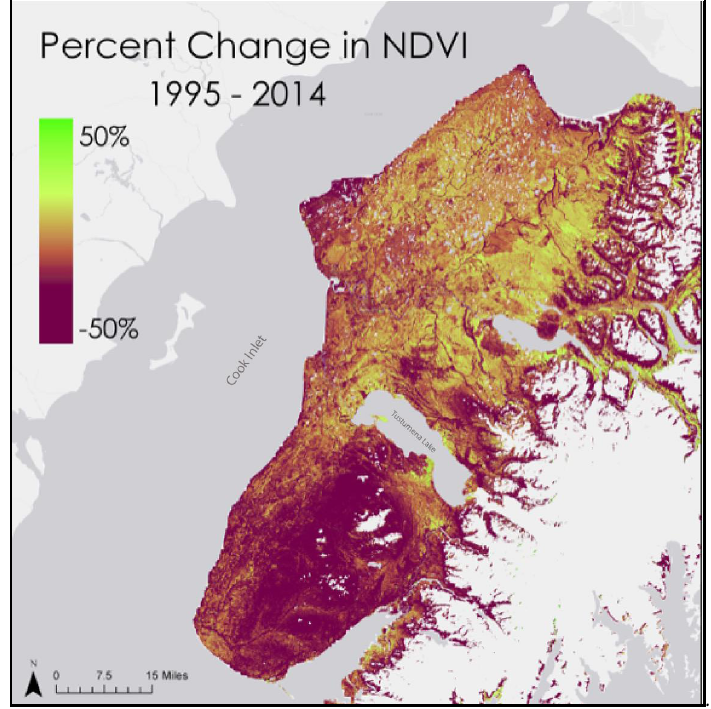
Figure 5. NDVI change between 1995 and 2014.